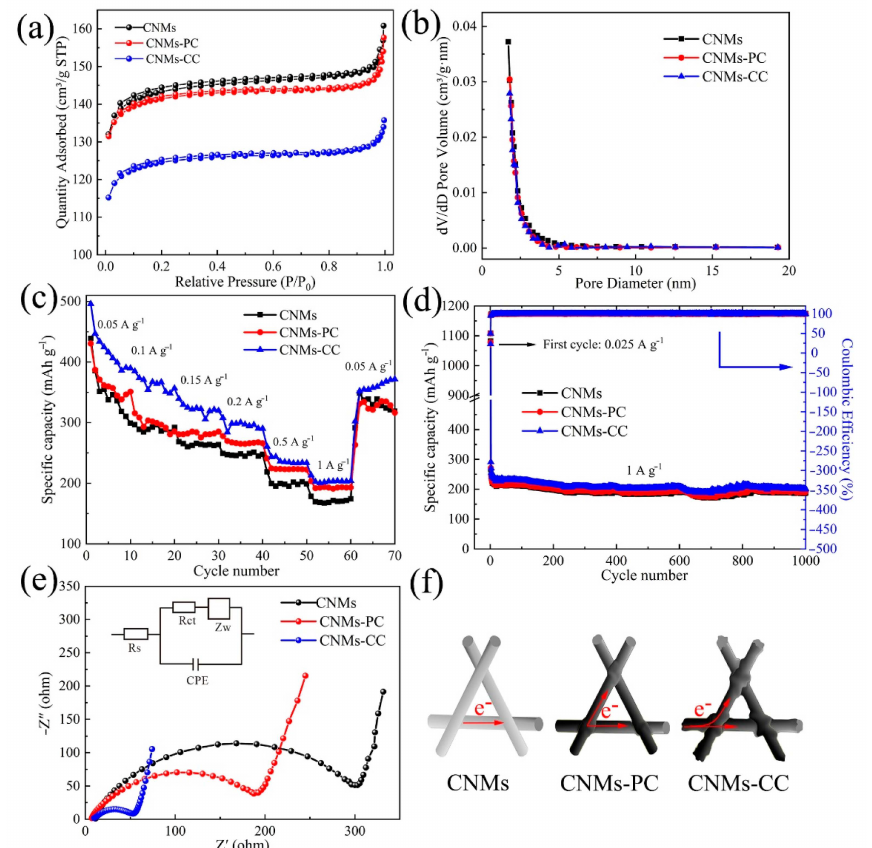
Figure 10. ( a ) N 2 adsorption − desorption isotherms, ( b ) BJH adsorption pore size distribution, ( c ) rate performance, ( d ) cycling performance, ( e ) EIS (Nyquist plots), measured at an amplitude of 5 mV over a frequency range of 100 kHz − 0.1 Hz, and ( f ) illustration of electron transfer for CNMs, CNMs − PC and CNMs −